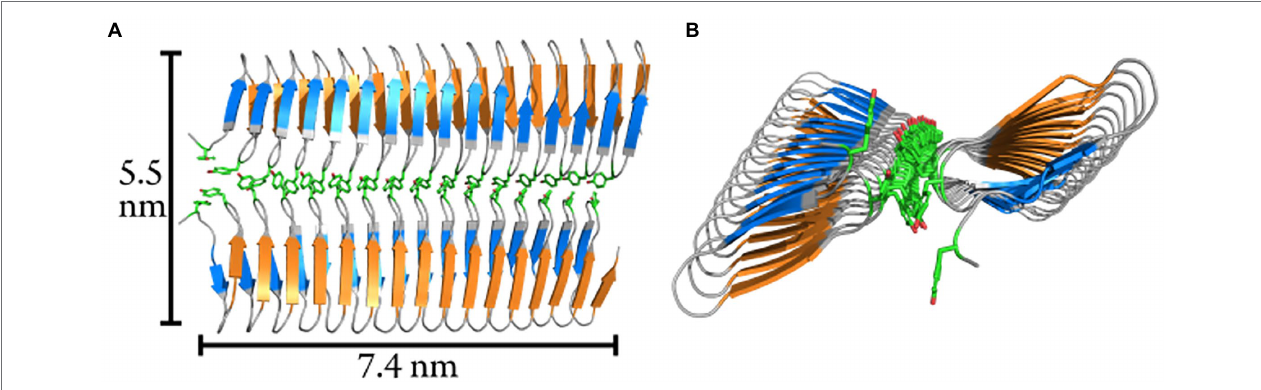
FIGURE 4 | Modelled homodimer structure of the initial 16-repeats of the INpro CRD domain. (A) The proposed homodimer structure of the INpro CRD. The tyrosine ladder comprises the dimerization interface. The monomers are parallel, and the TxT motif of one monomer is aligned with the SxL[T/I] motif of another monomer (blue and orange, respectively). The tyrosine ladder forms the dimerization interface. Approximate dimensions of the dimer surface are indicated. (B) End- view of the dimer model. The longitudinal rotation in the β -helix causes the dimer to form a saddle-like